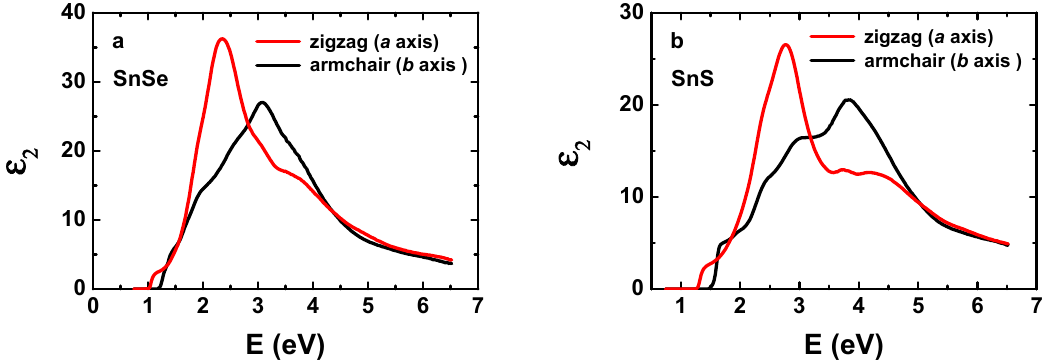
Figure 5. Comparison of the imaginary parts of the dielectric functions along the zigzag and armchair directions of SnSe ( a ) and SnS ( b ).